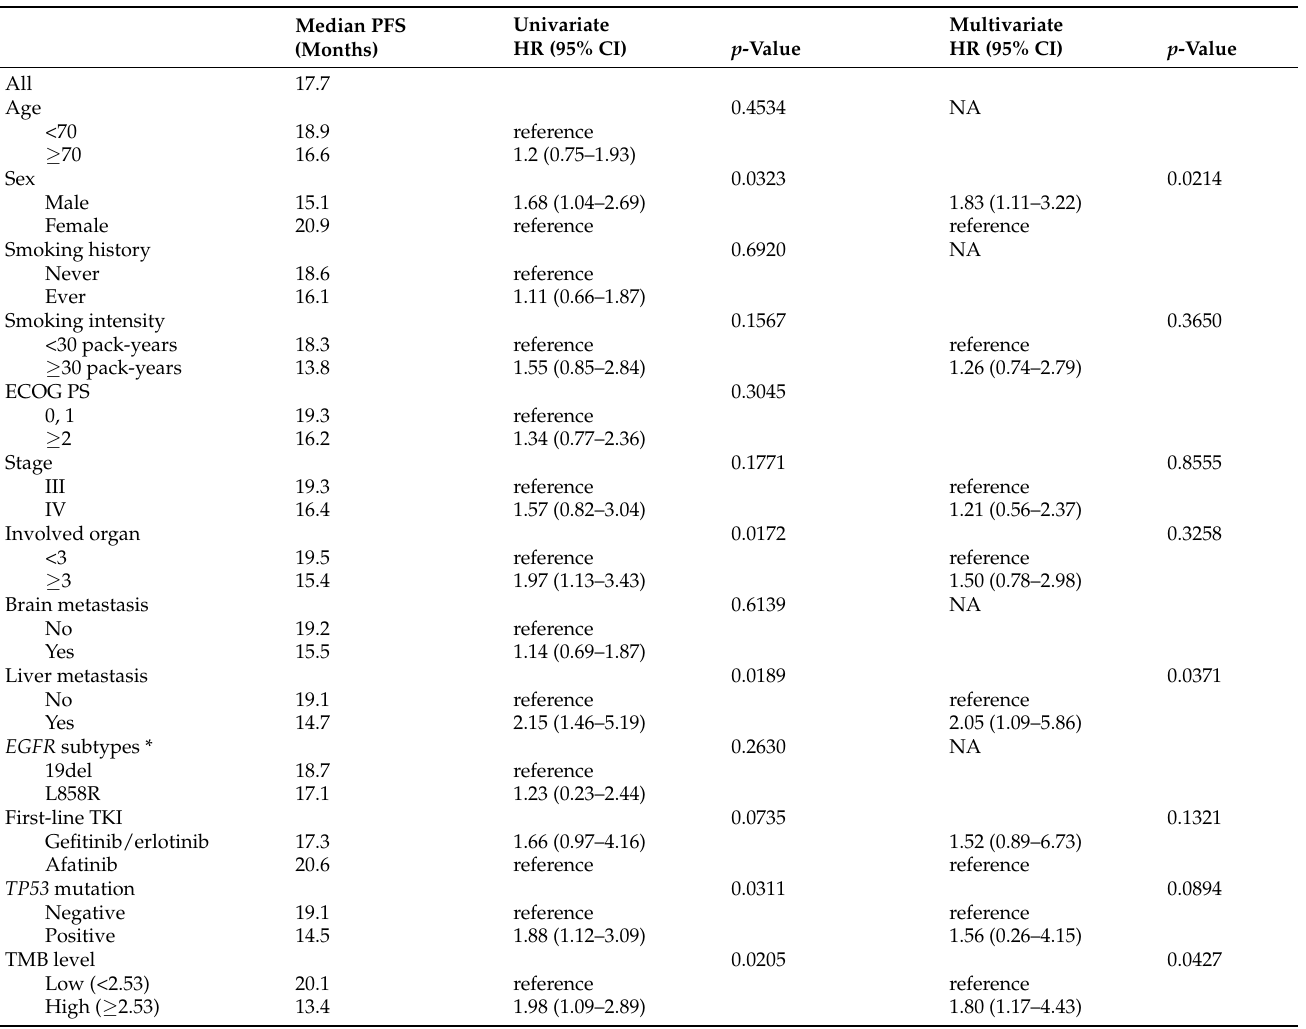
Table 3. Progression-free survival analyses results according to clinicopathological parameters of all the study